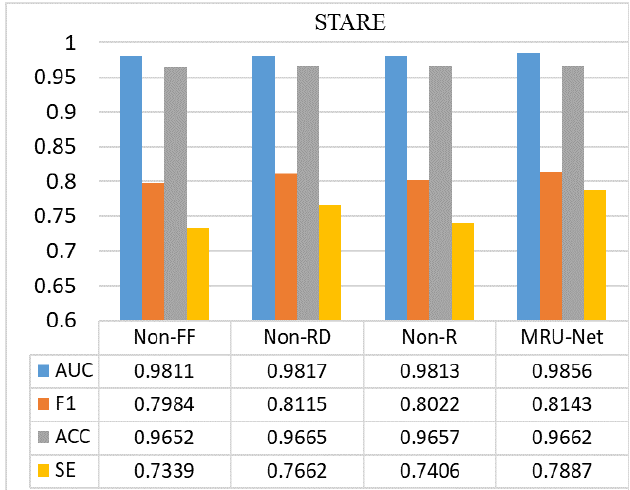
Figure 14. Comparison of STARE results: comparison of the indexes of different model structures in our proposed